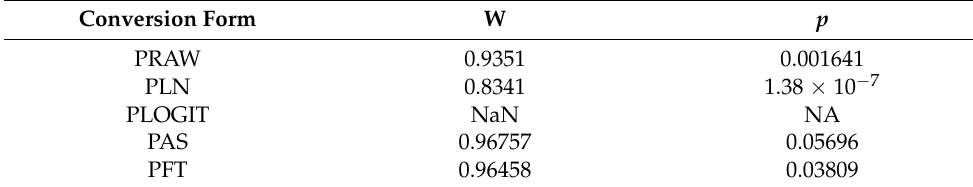
Table 2. Normal distribution test for the normal rate and the different conversion of the normal rate.